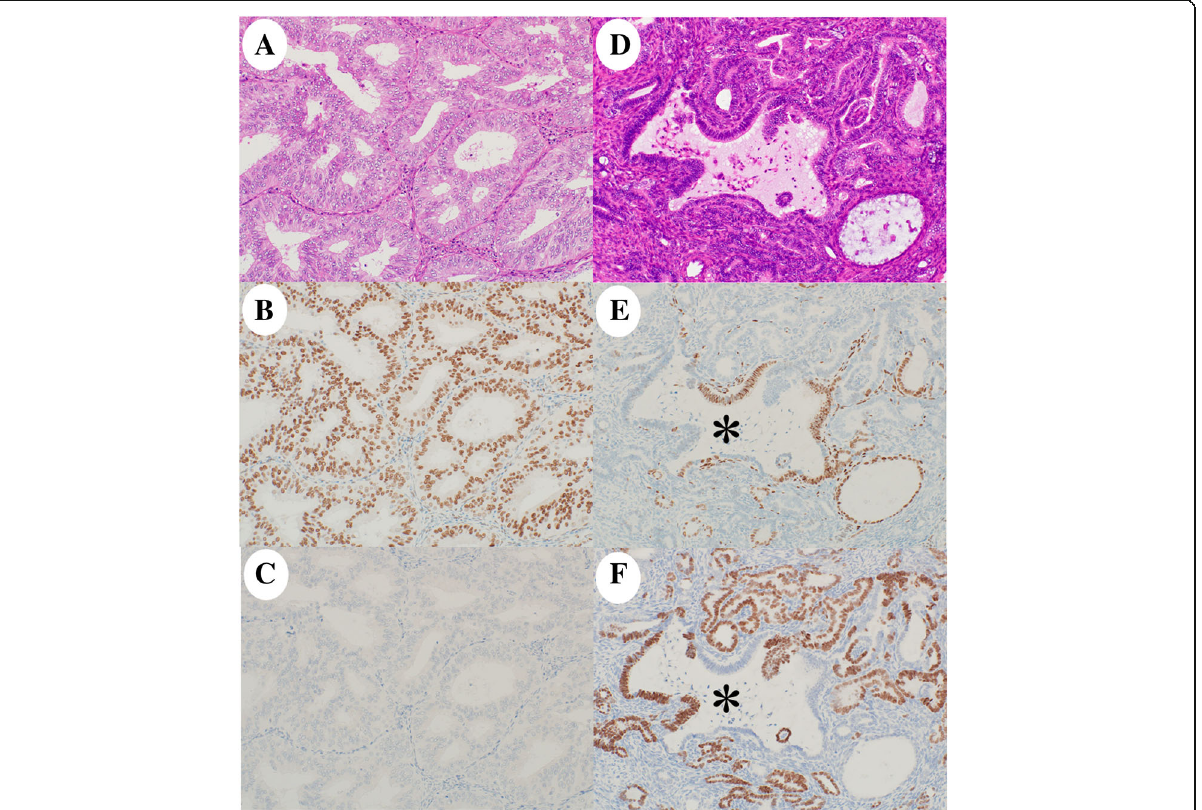
Fig. 3 Histology and immunohistochemistry of the initially diagnosed tumor. The tumor had ( a , 20×) a low-grade endometrioid carcinoma component and ( d , 20×) a mesonephric-like adenocarcinoma component. Immunohistochemically, the endometrioid carcinoma was diffuse positive for ( b , 20×) estrogen receptor (ER) and negative for ( c , 20×) thyroid transcription factor 1 (TTF-1). The mesonephric-like adenocarcinoma showed a transition pattern with a mixture of cells positive for ( e , 20×) ER- (a Müllerian duct marker) and ( f , 20×) TTF-1- (a Wolffian duct marker) within the same glands